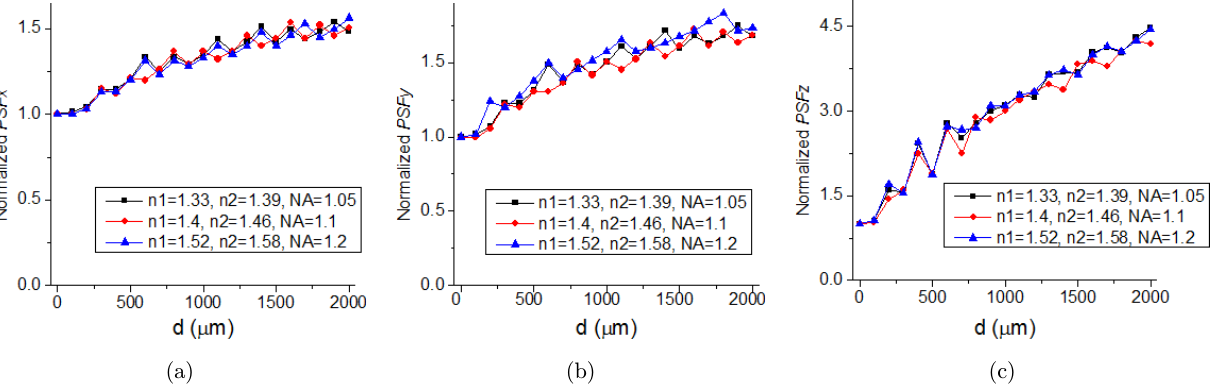
Fig. 7. Normalized two-photon (a) PSF x , (b) PSF y and (c) PSF z vs imaging depth for 1700-nm excitation but with di®erent immersion media and NAs. Also (cid:2) n ¼ 0 : 06. The n 1 , n 2 and NA values are indicated in the